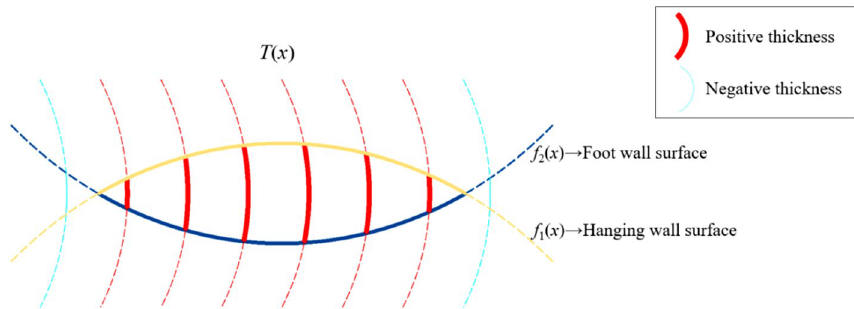
Figure 5. A schematic diagram of the thickness distribution of signed thickness